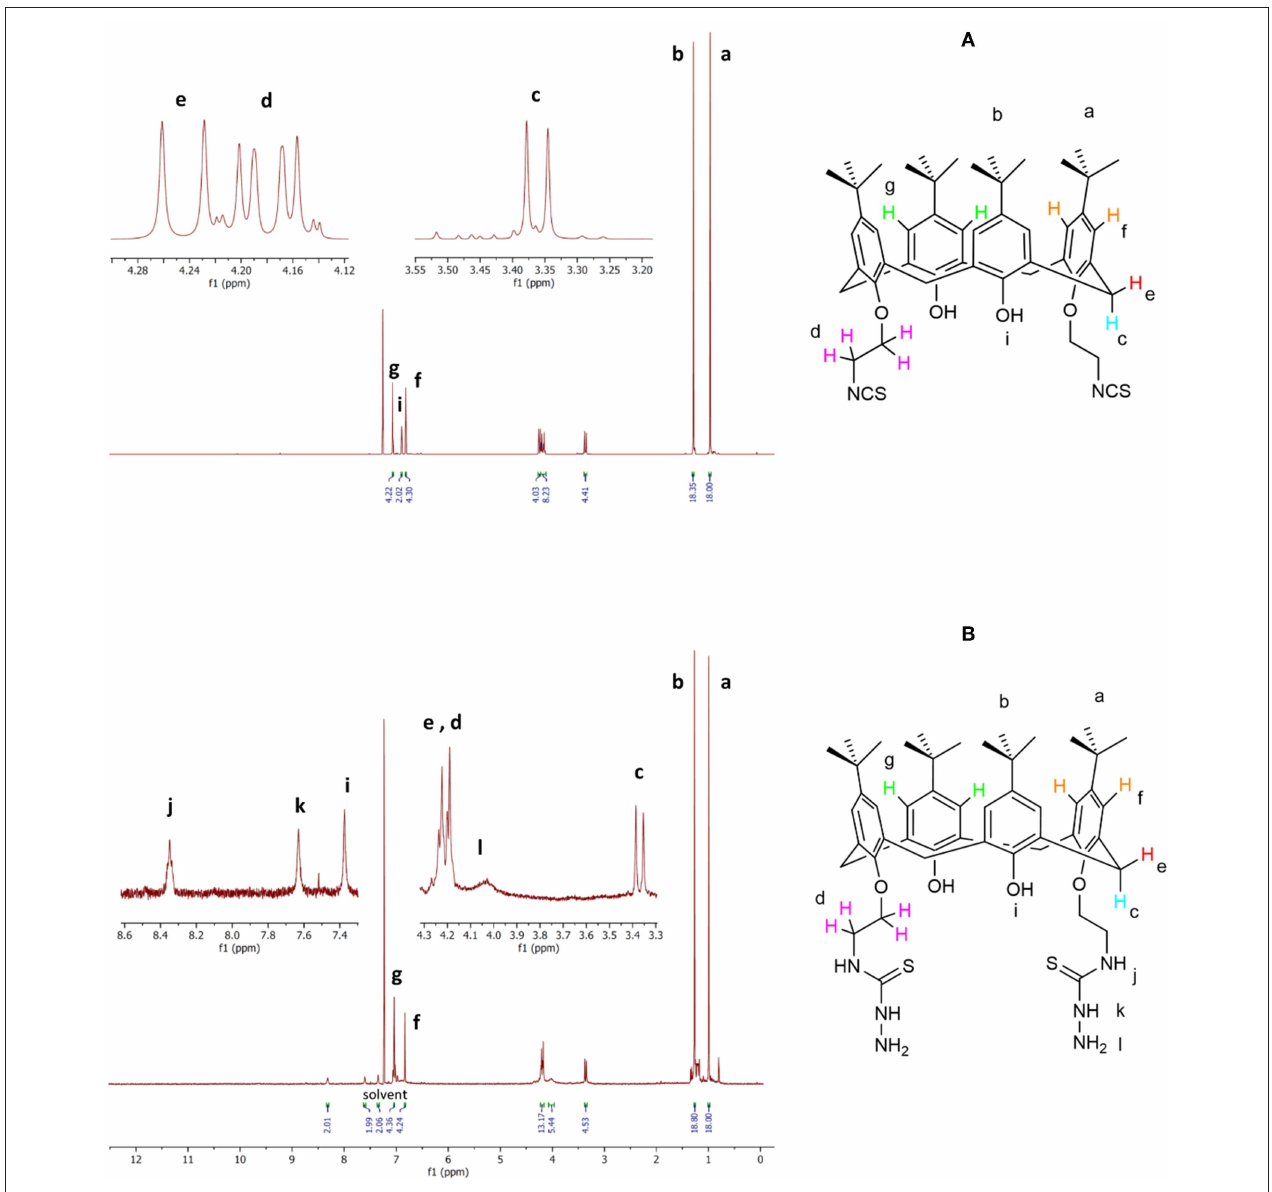
FIGURE 3 | Selected portion of the 1 H-NMR spectra of compound 4 (A) and ligand L (B)